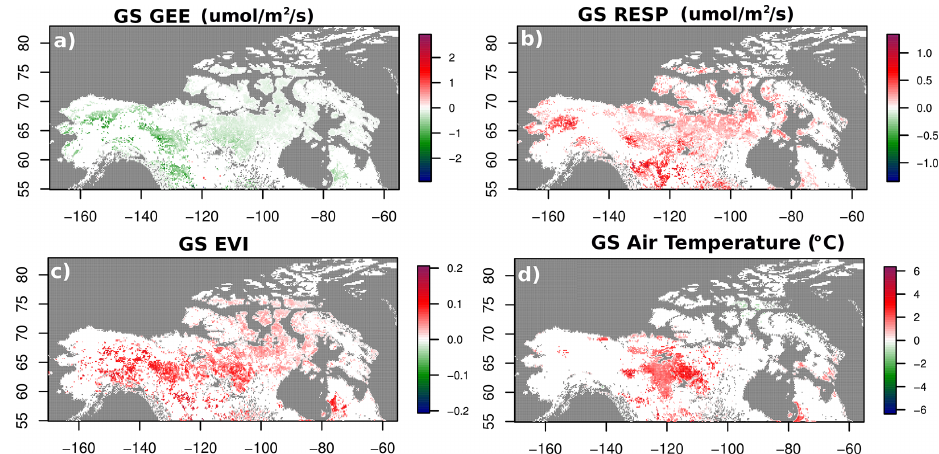
Figure 8. Sen’s slope of median change (2001–2012) in PolarVPRM estimates of growing season carbon cycle variables, and driver data. All statistically significant ( p value < 0 . 05) changes over time in carbon cycle variables and driver data are shown for the growing season (GS, when SCA < 50% AND GEE < 0). Please note that as the growing season includes only the period of time for which vegetation is productive at any pixel (GEE < 0), periods of time for which air temperature extremes or drought hinder photosynthesis are not included. The influences of rising EVI and air temperatures on increasing Arctic rates of photosynthesis are therefore made clear, whereas plots of annual GEE (Fig. 7) emphasize reductions in photosynthetic uptake of C by forest